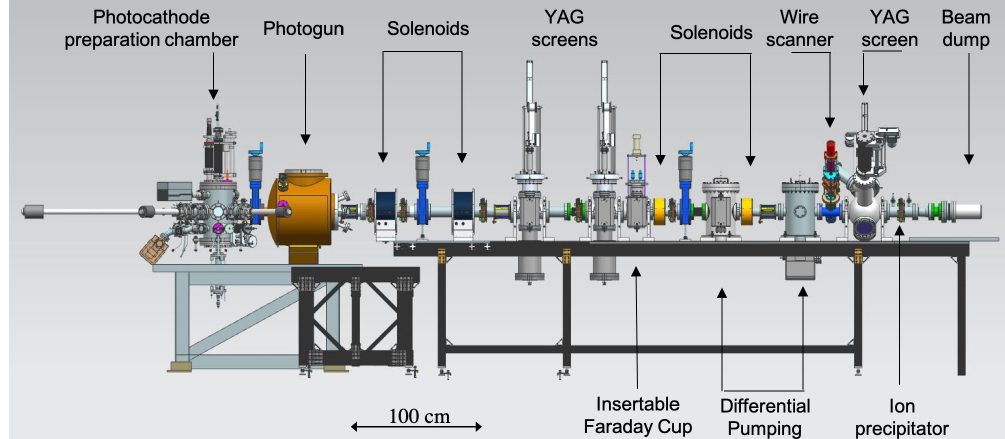
FIG. 5. Schematic of the photogun test stand and diagnostic beam